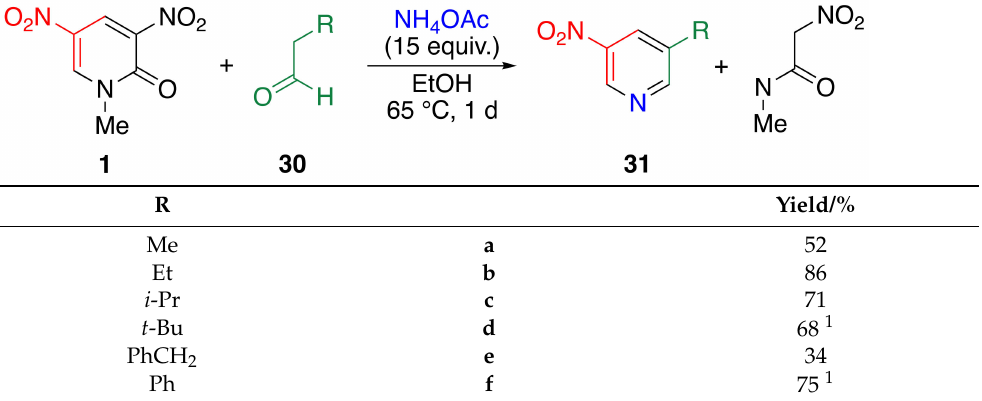
Table 7. TCRT with aldehydes 30